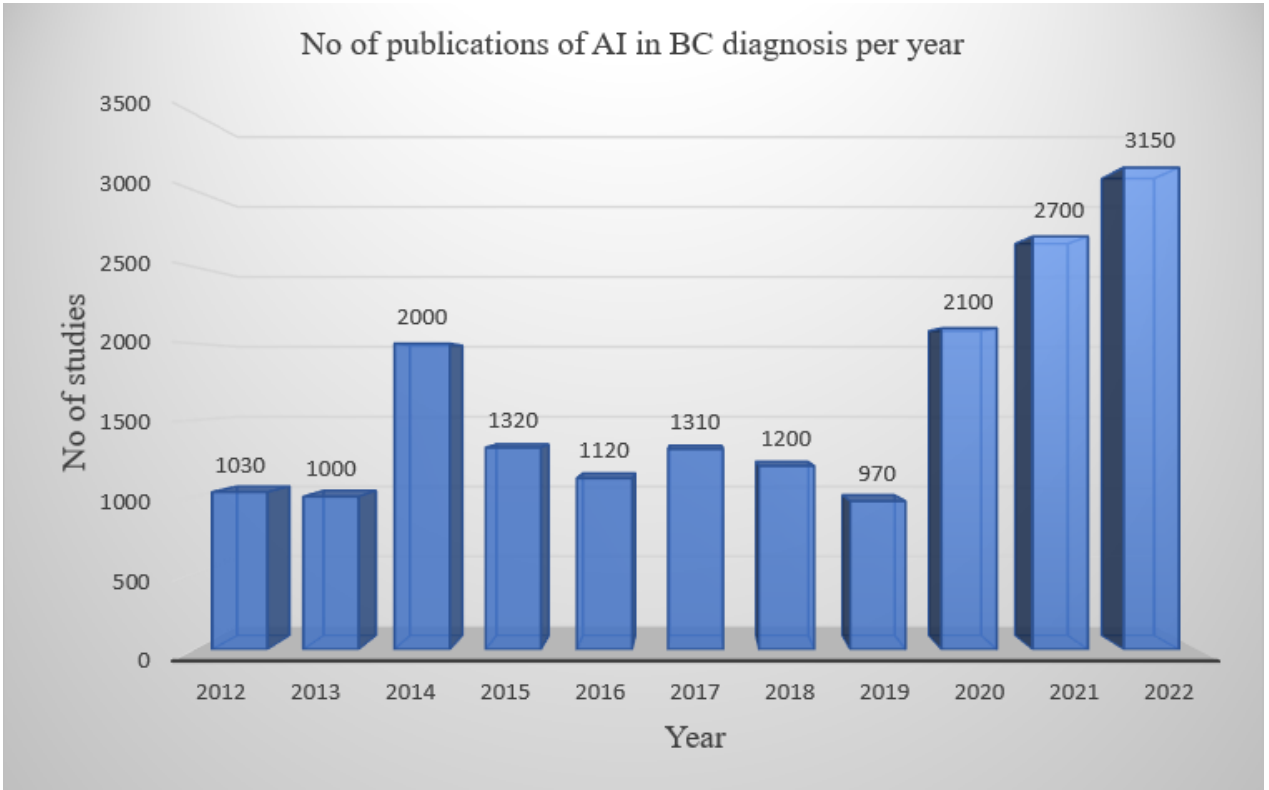
Figure 2. Showing publications on AI in breast cancer diagnosis between 2012–2022.